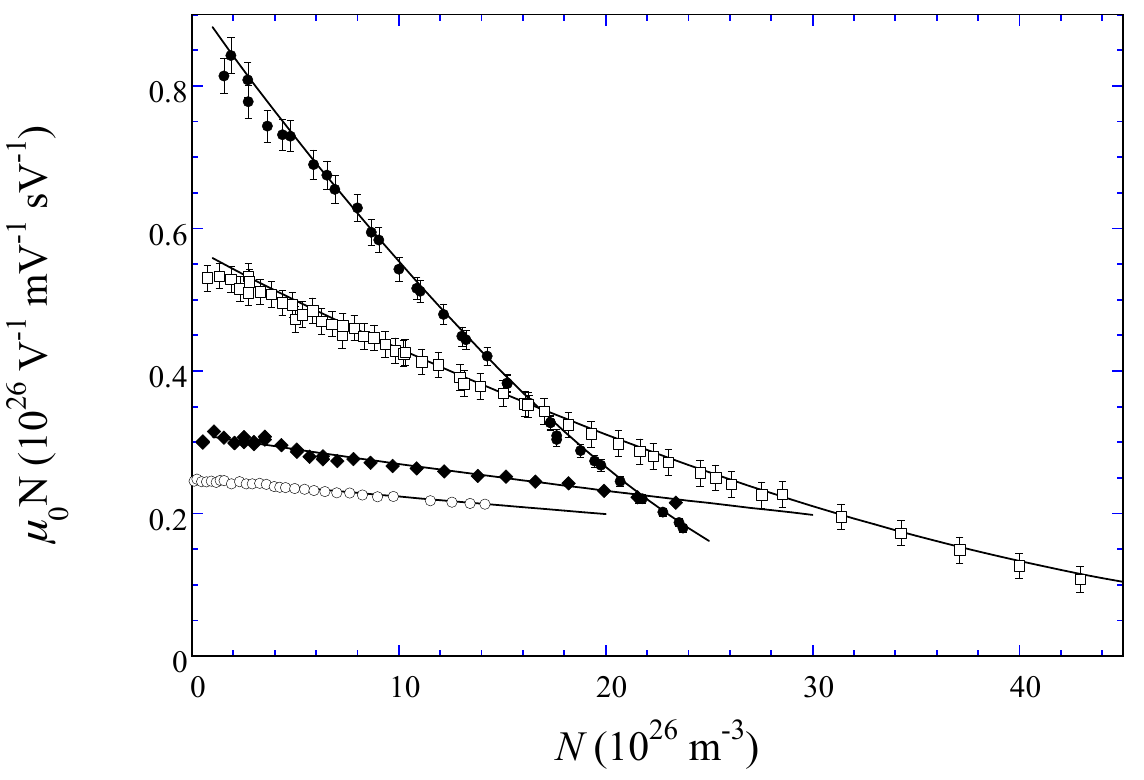
Figure 4. µ 0 N vs. N . T = 26.1K (closed points), T = 64.4K (open squares), T = 199.5K (closed diamonds), and T = 295.5K (open points). Lines: heuristic model prediction. The data are only presented for N still either absent or present in a negligible proportion. The error bars for the highest T are of the same size of the dots and are not